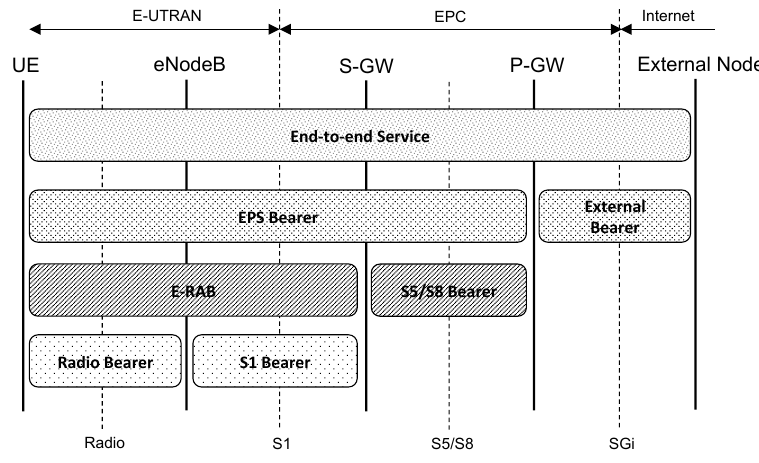
Figure 16. Bearers in an LTE